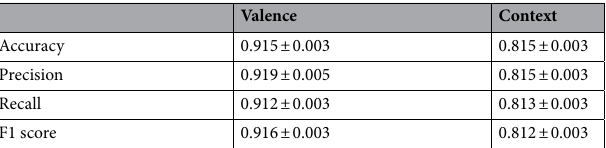
Table 2. Performance statistics for neural networks trained on valence and context of production. For the binary valence classifier (2 classes: positive and negative), the following statistics were computed using the binary precision, recall, and F1 score formulas while treating positive valence labels as positive. For the imbalanced multi-class context classifier (19 classes, Supplementary Table S1), the following statistics were calculated as weighted averages across the classes. From the 10 trials, the mean accuracy, precision, recall, and F1 scores of the classifiers are listed. The uncertainty value is calculated across 10 trials.